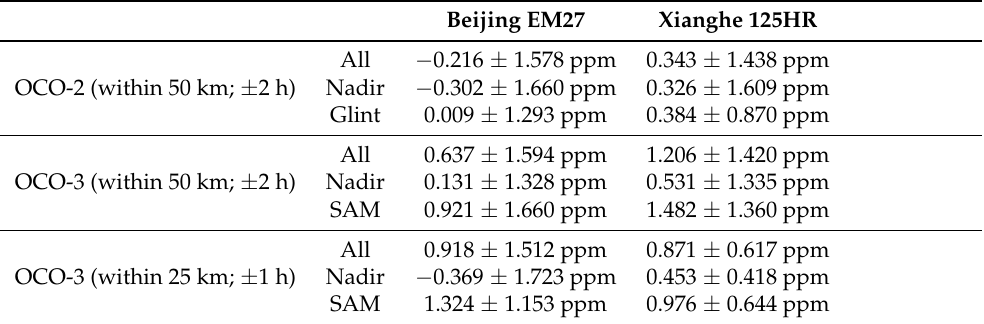
Table 2. The mean and std of the difference between co-located ground-based FTIR and OCO-2/3 satellite measurements (SAT-GB) for all satellite observation modes and for each individual mode. Beijing EM27 Xianghe 125HR All − 0.216 ± 1.578 ppm 0.343 ± 1.438